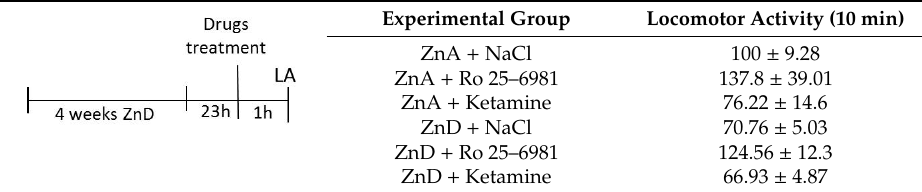
Table 1. Effect of zinc deficient diet (ZnD) and Ro 25–6981 and ketamine treatment on the locomotor activity of rats.